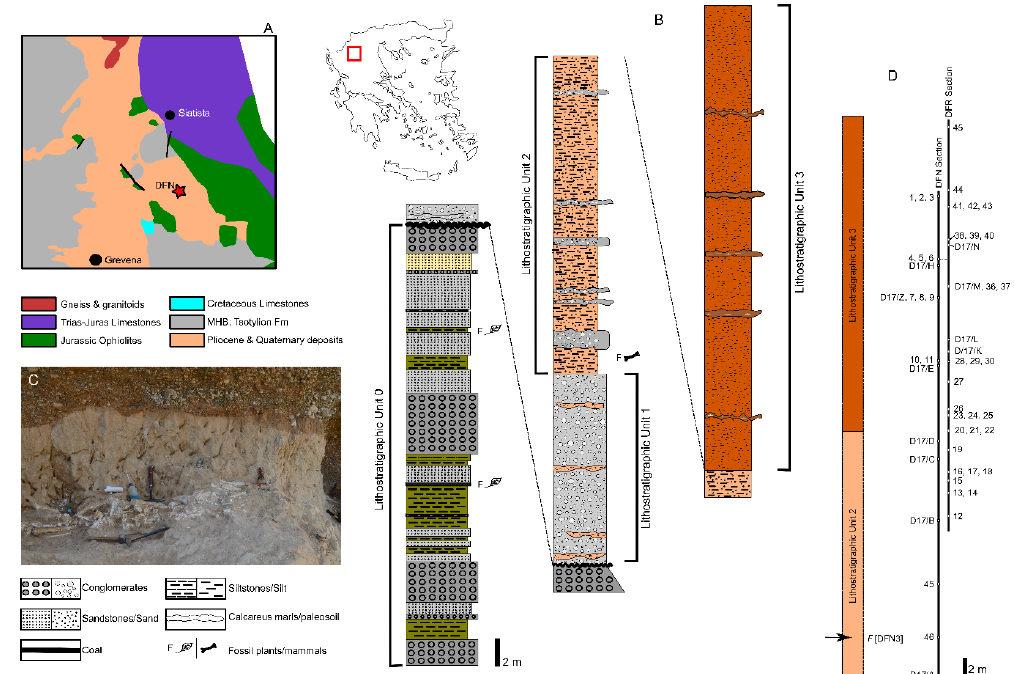
Figure 1. Geographic and geological setting of the Dafnero fossil sites. ( A ) Simplified geological map of the studied area (from [37], redesigned). ( B ) Composite stratigraphic section of Dafnero sedimentological sequence; F denote fossiliferous level. ( C ) Example of fossil accumulation at DFN3 fossil site indicating local sedimentological setting. ( D ) Position of palaeomagnetic sampling and correlation between the two sampled sections from Dafnero area.